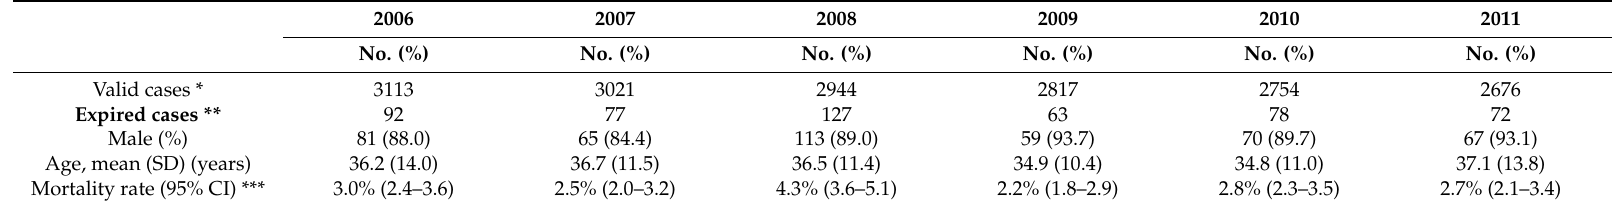
Table 2. Valid cases enrolled in 2005 and followed-up from